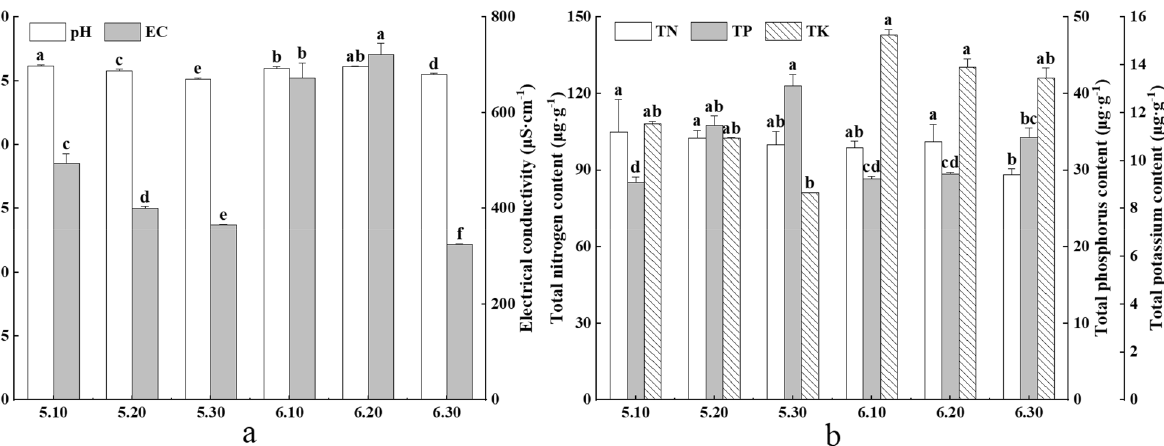
Figure 1. Changes in physicochemical factors and nutrient elements in earthworm mucus induced by different electrical stimuli. 5.10, 5.20, 5.30, 6.10, 6.20, 6.30 indicate 5 V 10 mA, 5 V 20 mA, 5 V 30 mA, 6 V 10 mA, 6 V 20 mA, and 6 V 30 mA, respectively; Data are presented as the mean ± SD for three duplicates, n = 3. To test for significance difference between different treatment groups, one-way analysis of variance (ANOVA) was used. Different lowercase letters indicate significant differences of the same index under different electrical stimuli ( P < 0.05); EC electrical conductivity, TN total nitrogen, TP total phosphorus, TK total